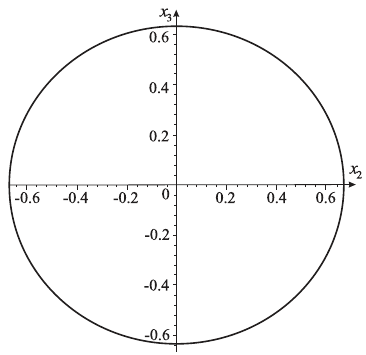
Fig. 2. Cross section of the (cid:12)gure in the Ox 2 x 3 plane. Here {2/3 (cid:20) x 2 =x ∗ 1 (cid:20) 2/3, and x 3 is the root of the cubic equation 3 = 2 x − 1 curve resembles an ellipse with a small oblateness ( " (cid:25)